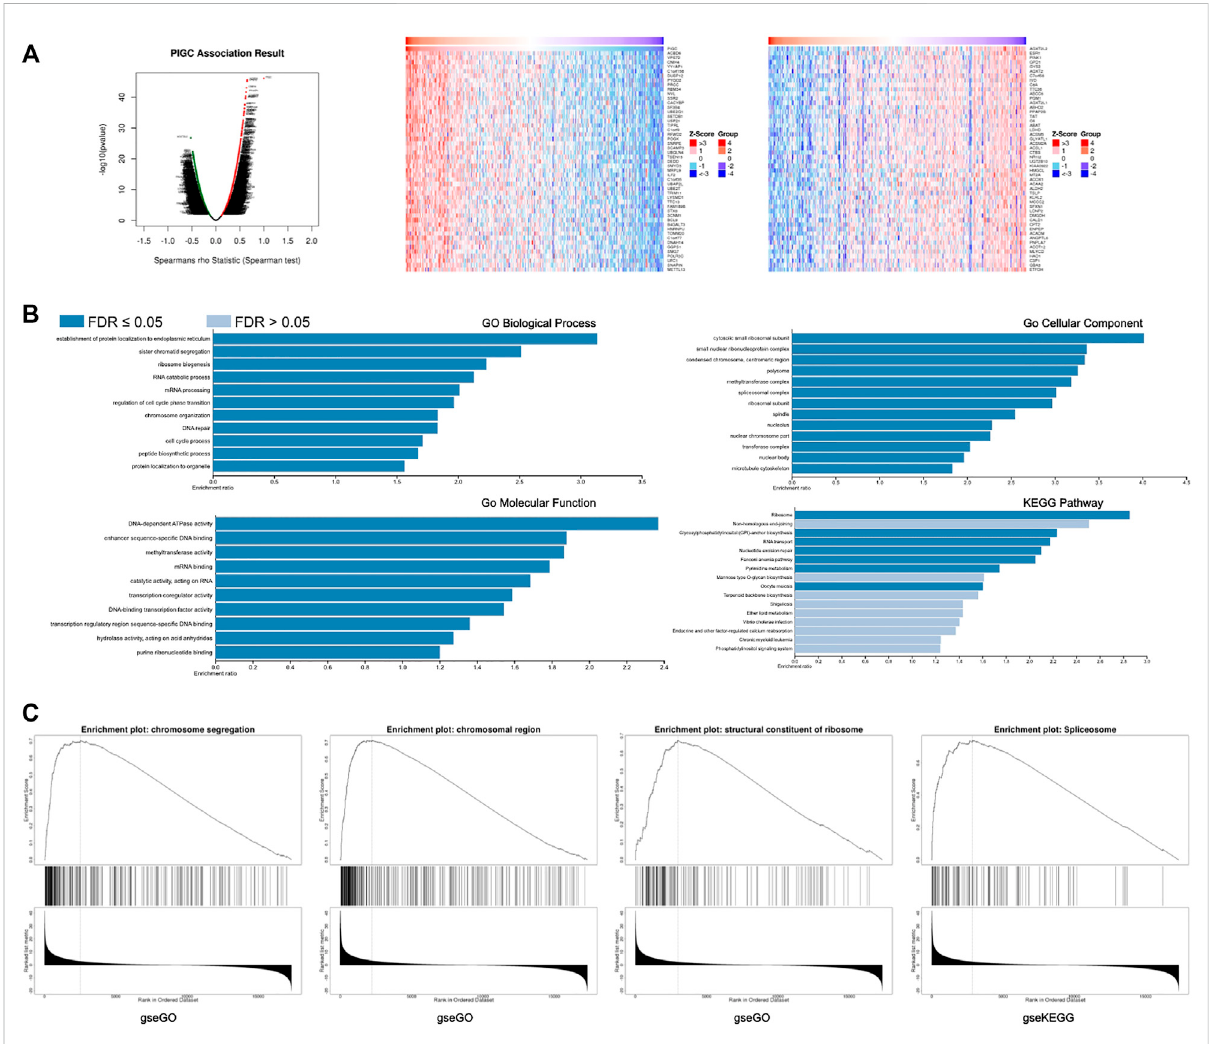
FIGURE 6 Theco-expressionofgeneswith PIGC inHCC (A) TheglobalPIGChighly correlatedgenesidenti fi edbyPearsontestinLIHC cohort.Signi fi cant positive correlations highlighted in red, signi fi cant negative correlations in green. And the heat maps showing top 50 genes positively and negatively correlated with PIGC in LIHC. Red indicates positively correlated genes and blue indicates negatively correlated genes. (B) Co-expressed genes pro fi le with the PIGC gene involved in signaling pathways in HCC via ORA tool. (C) Co-expressed genes pro fi le with the PIGC gene involved in signaling pathways in HCC via GSEA